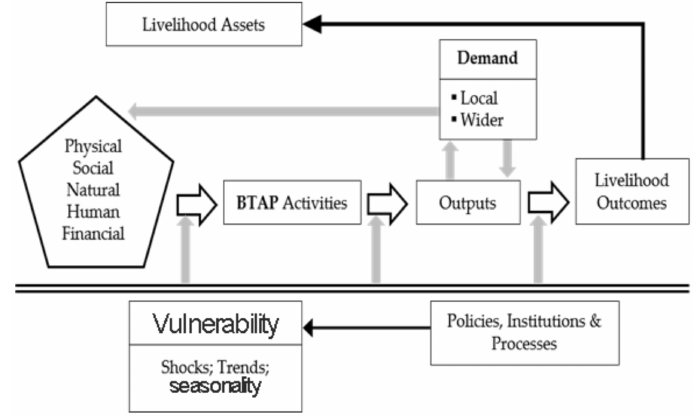
Figure 2. Sustainable rural livelihood framework (SLF) thinking framework on BTAP